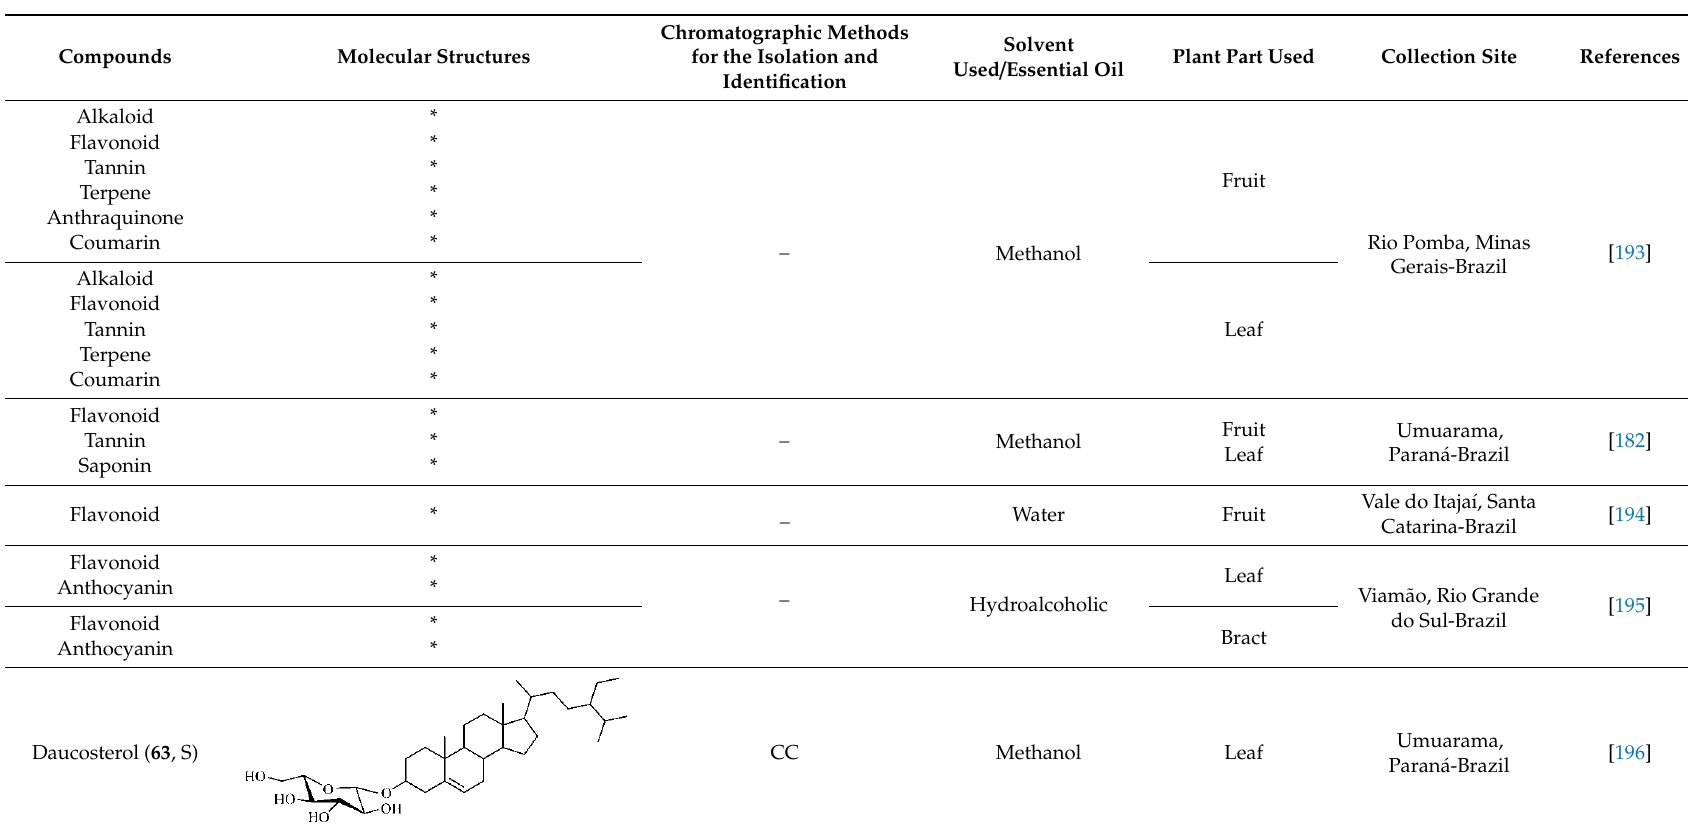
Table 4. Phytochemical analysis of B. antiacantha.